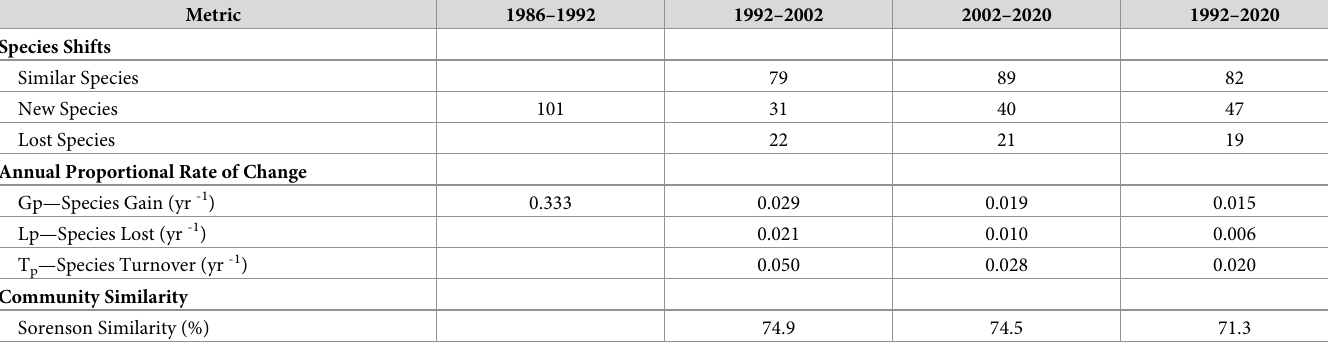
Table 4. Rates of species gains, loss, and turnover of the vegetation community of Quarry